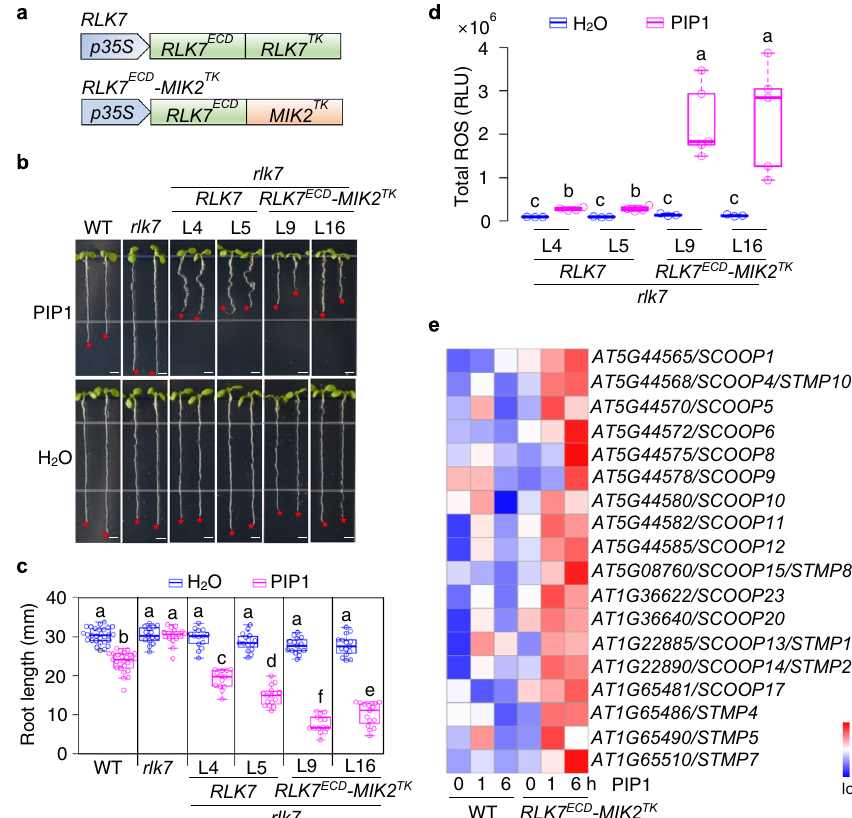
Fig. 1 Activation of the cytosolic kinase domain of MIK2 induces SCOOP expression. a Diagram of the RLK7 ECD -MIK2 TK chimeric receptor gene. RLK7 ECD - MIK2 TK chimeric gene encoding RLK7 extracellular domain ( RLK7 ECD ) and MIK2 transmembrane and cytoplasmic kinase domains ( MIK2 TK ) and the full-length RLK7 ( RLK7 ECD -RLK7 TK ) driven by the CaMV35S promoter were transformed into rlk7 . b , c RLK7 ECD -MIK2 TK / rlk7 transgenic seedlings show more severe root growth inhibition to PIP1 treatment than RLK7/rlk7 seedlings. Images of 10-day-old seedlings of Arabidopsis WT (Col-0), rlk7 , two representative lines (L9 and L16) of RLK7 ECD -MIK2 TK / rlk7 , and two lines (L4 and L5) of RLK7/rlk7 grown on ½MS plates with or without 1 µ M PIP1: red stars indicate the root tips, scale bar, 4 mm ( b ; quanti fi cation of root length of seedlings ( c )). d PIP1 treatment induces a more pronounced ROS production in RLK7 ECD -MIK2 TK / rlk7 than that in RLK7/rlk7 transgenic seedlings. One-week-old seedlings grown on ½MS plates were treated with H 2 O or 100 nM